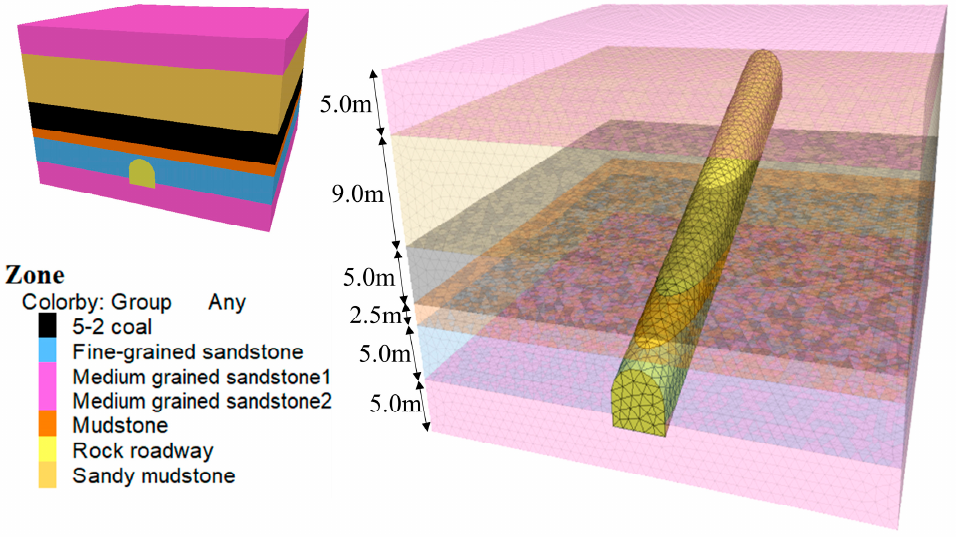
Figure 4. Numerical model.